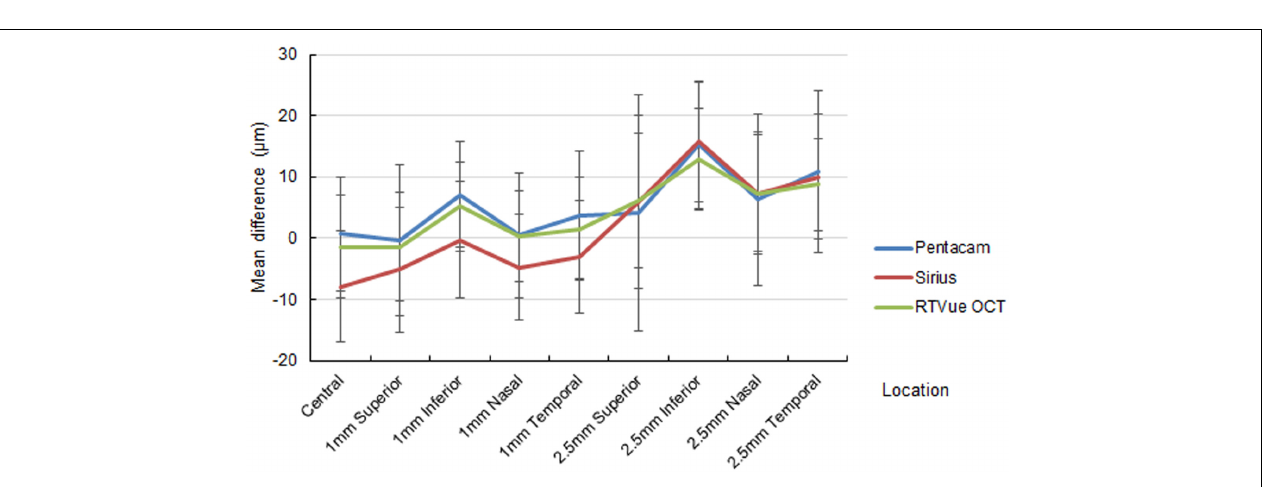
FIGURE 2 | Mean difference of the predicted ablation depth against actual measured corneal ablation depth determined by Pentacam HR (blue line), Sirius (red line), and RTVue OCT (green line) at three months